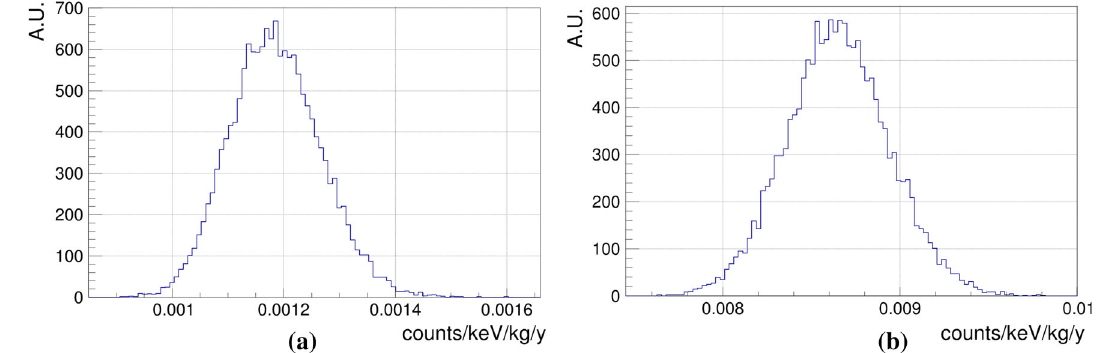
Fig. 5 Global pdf’s, accounting for internal correlations, for the BI contribution of a TeO 2 bulk and surface impurities and b CuNOSV bulk and surface impurities. The mean of each pdf is taken as the estimation of the global contribution to the CUORE background budget BI i